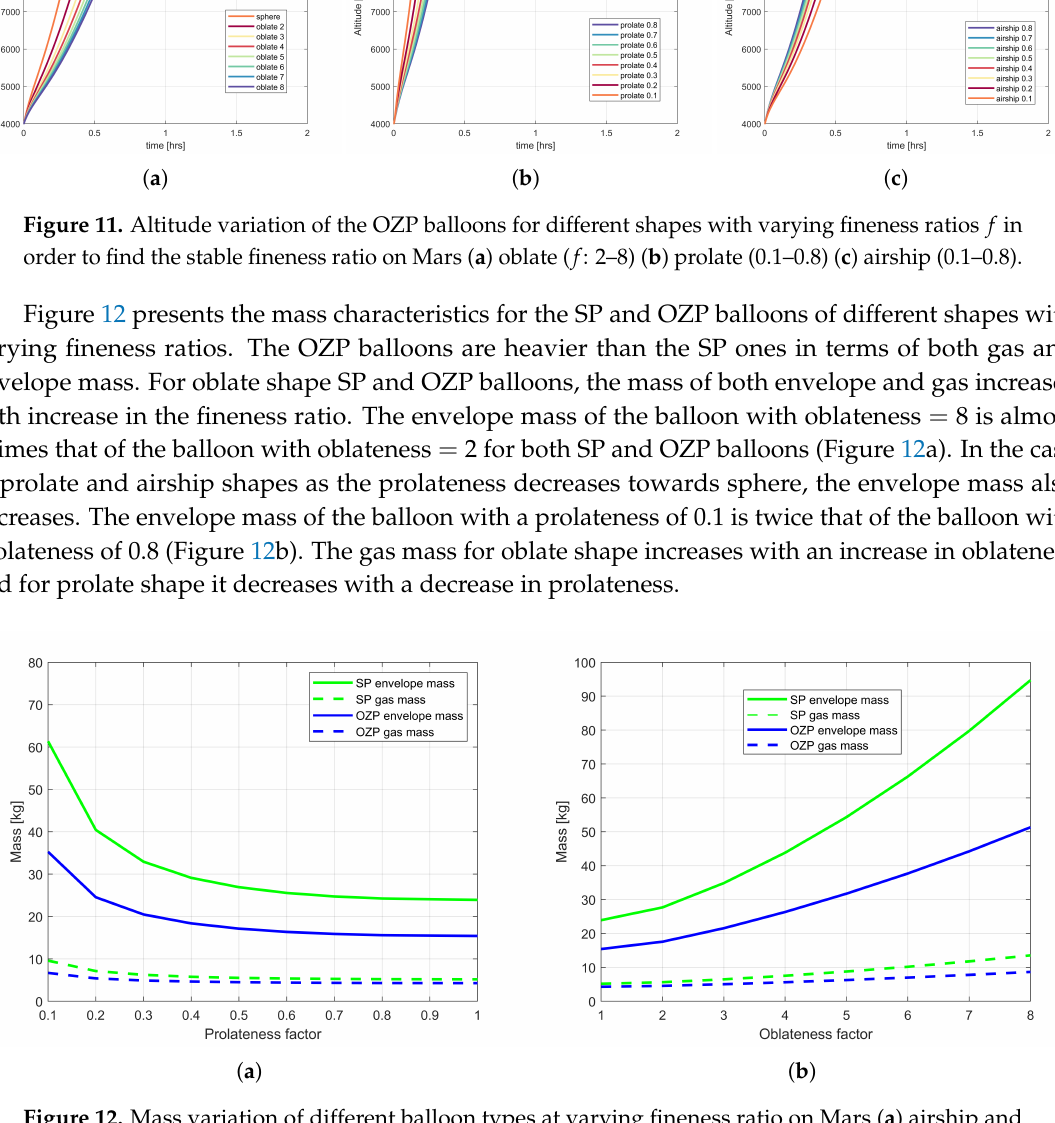
Figure 12. Mass variation of different balloon types at varying fineness ratio on Mars ( a ) airship and prolate ( b )